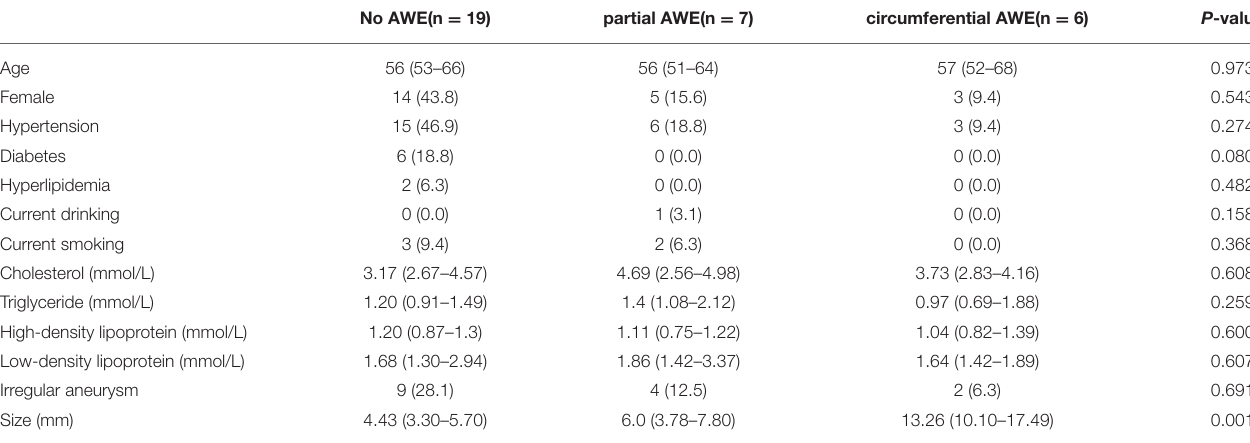
TABLE 1 | The clinical characteristics of unruptured intracranial aneurysms with different aneurysm wall enhancement (AWE) patterns. No AWE(n =